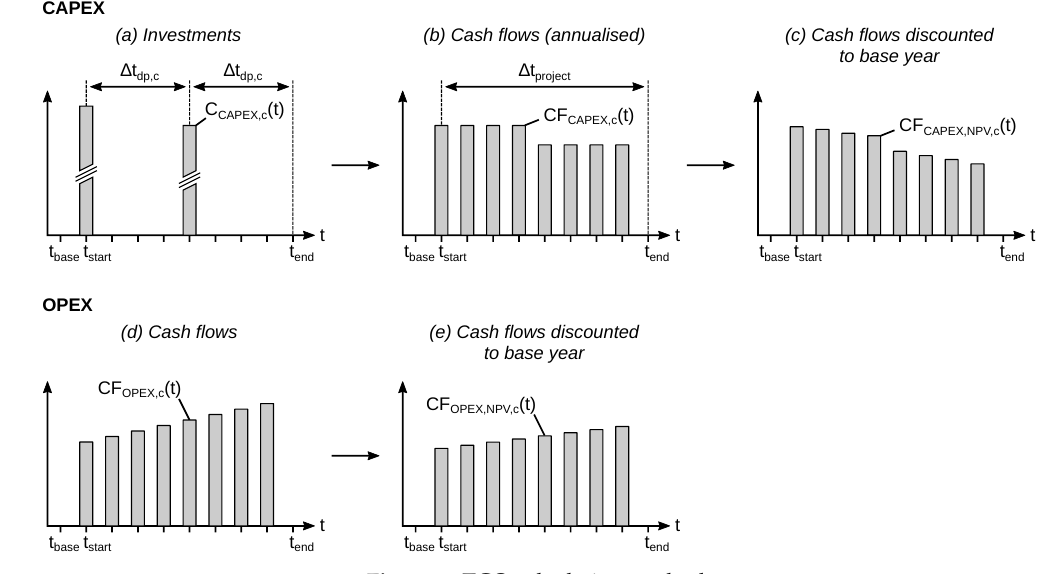
Figure 8. TCO calculation